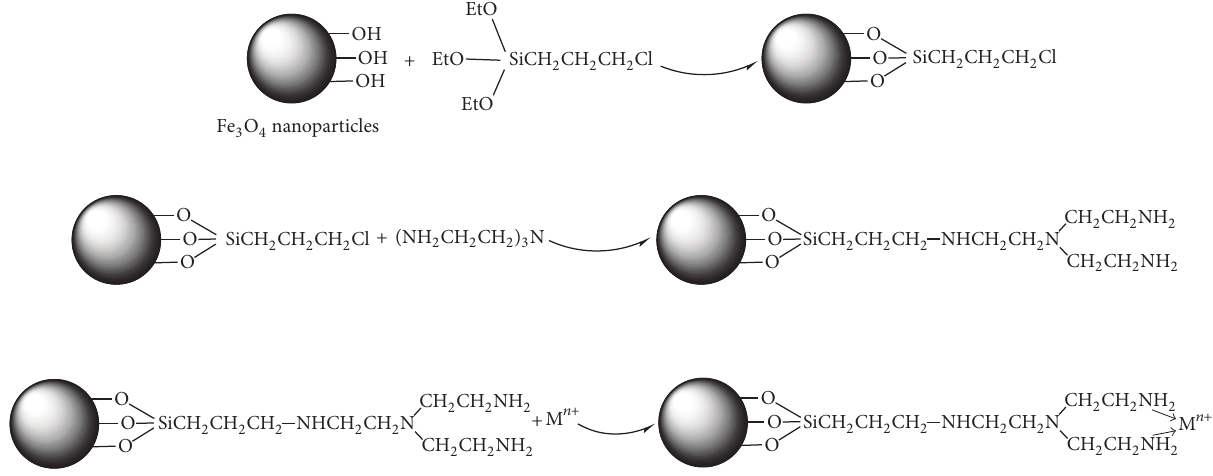
F 2: A schematic model for synthesis of TREN-functionalized Fe O